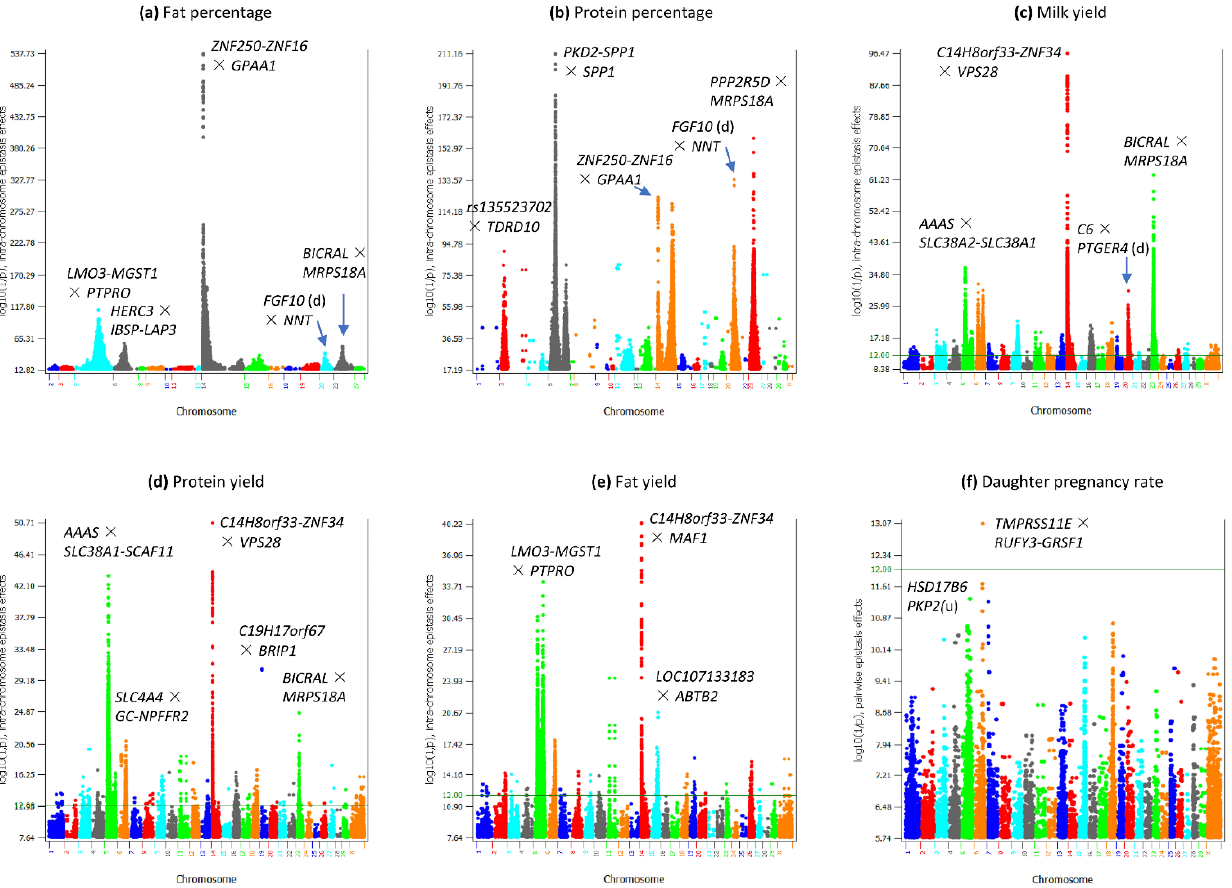
Figure 1. Manhattan plots of statistical significance of intra-chromosome epistasis effects for five milk production traits and daughter pregnancy rate. ( a ): Fat percentage. ( b ): Protein percentage. ( c ): Milk yield. ( d ): Protein yield. ( e ): Fat yield. ( f ): Daughter pregnancy rate.